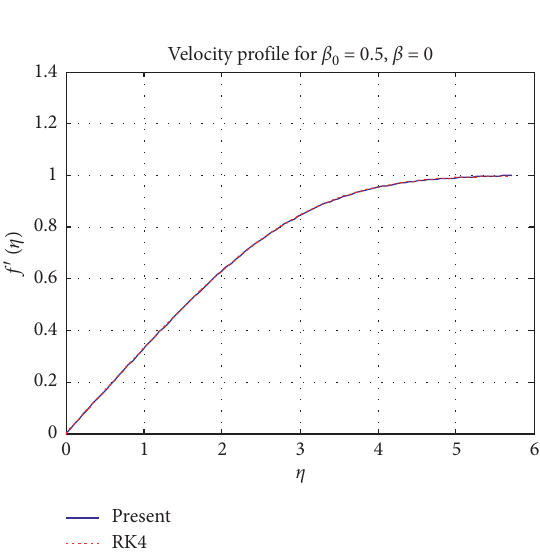
Figure 2: Velocity profile of the Blasius flow ( β